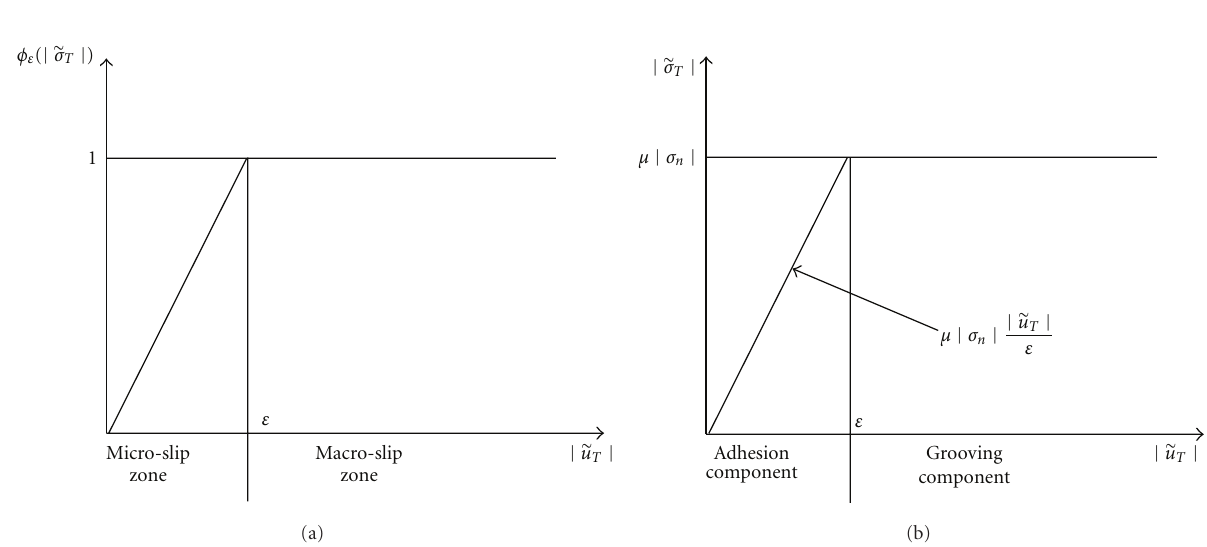
Figure 2: (a) Nonlinear function of Φ ε and (b) variation of the tangential contact